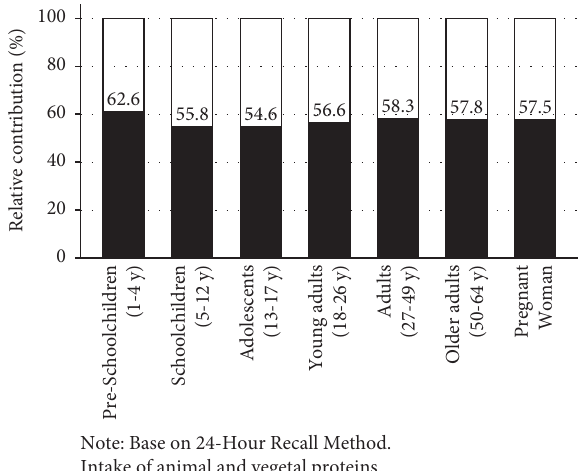
Note: Base on 24-Hour Recall Method. Intake of animal and vegetal Figure 1: Relative contribution (%) to total protein intake in the Colombian population. National Survey of Nutritional Situation in Colombia (ENSIN-2015). Animal protein (black); vegetal protein